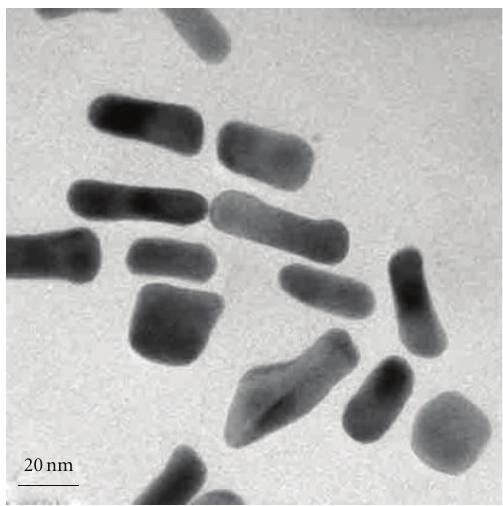
Figure 1: SEM image of gold nanorods.